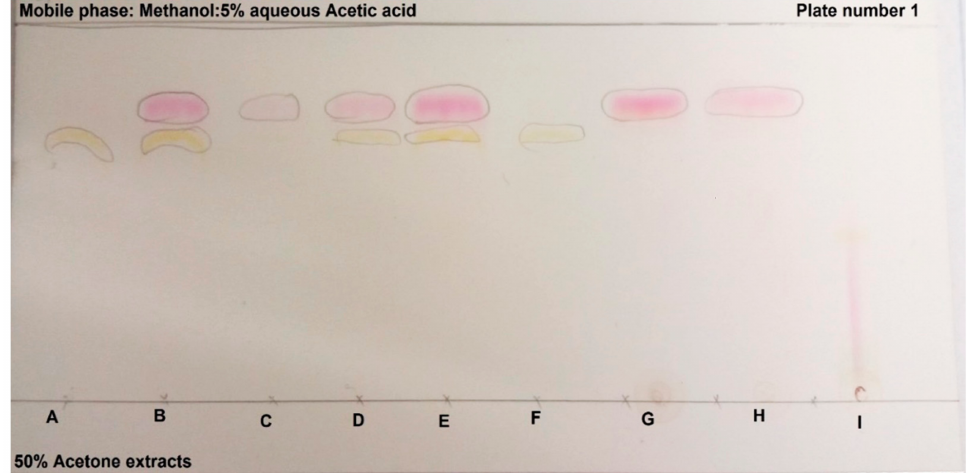
Figure 1. TLC plate visualized under short and long wavelength, ( A ) Ficus Indice; ( B ) Monterey;